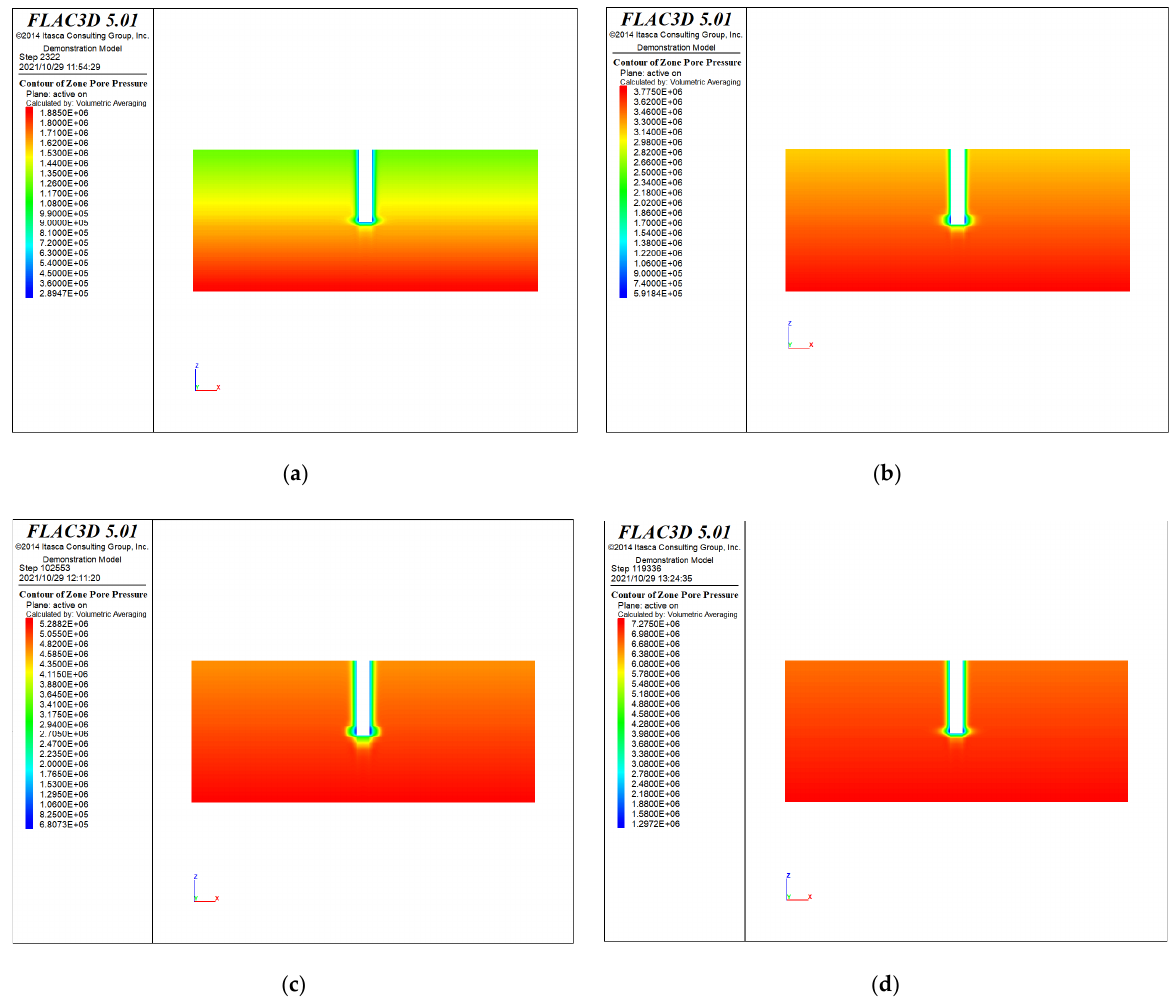
Figure 7. Hydraulic pressure field of different excavation sections without grouting. ( a ) Aq1, ( b ) Aq2, ( c ) Aq3, ( d ) Aq4.